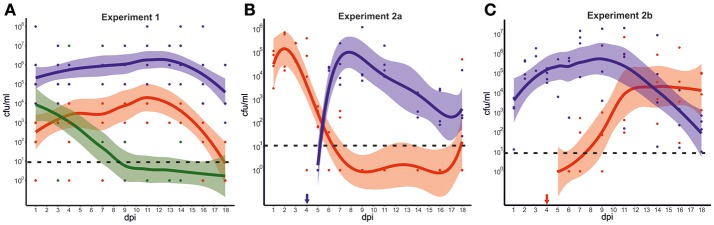
Experimental infection of mallards with C. jejuni strains of various hosts. (A) Colonization dynamics in mallards during infection with C. jejuni strains isolated from mallard (blue), chicken (red), and song thrush (green). The graph illustrates the predicted smoothed mean value for each strain with 95% confidence bands based on the mean colony forming units (cfu) per ml of initial suspension for all fecal samples at each time point, as measured by plate counts. Each dot represents fecal cfu/ml from one bird at each time point. Zeros were replaced for one to fit a log scale. (B,C) Colonization dynamics in mallards during mixed infection with strains isolated from mallard (blue) and chicken (red). The graphs illustrate the predicted smoothed mean value for each strain with 95% confidence bands corresponding to the mean cfu/ml of initial suspension for all fecal samples at each time point, as determined by real-time PCR with CT-values transformed to cfu/ml. In experiment 2a, birds were infected at 0 dpi with the chicken strain followed by the mallard strain at day 4 dpi (indicated by blue arrow). (B) In experiment 2b, birds were infected at 0 dpi with the mallard strain followed by the chicken strain at 4 dpi (indicated by red arrow). (C) Zeros were replaced for 1 to fit a log scale. The dashed line indicates the theoretical limit of detection.